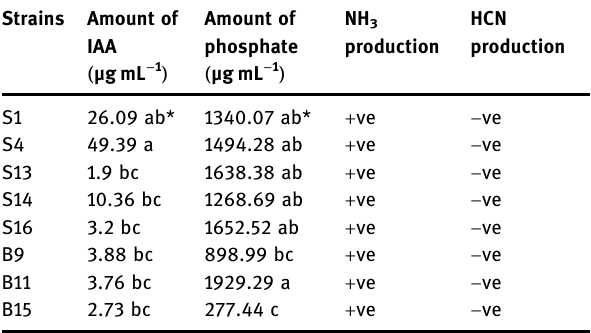
Table 3: Amount of phosphate and IAA produced according to bacterial isolates Strains Amount of